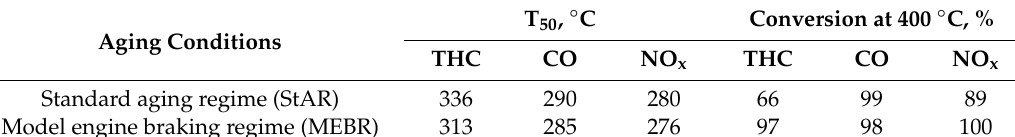
Table 1. Light-o ff parameters for the aged samples of Rh / (Al 2 O 3 -CeZrO 2 ) catalyst. Table 1. Light-off parameters for the aged samples of Rh/(Al 2 O 3 -CeZrO 2 ) catalyst. Aging Conditions